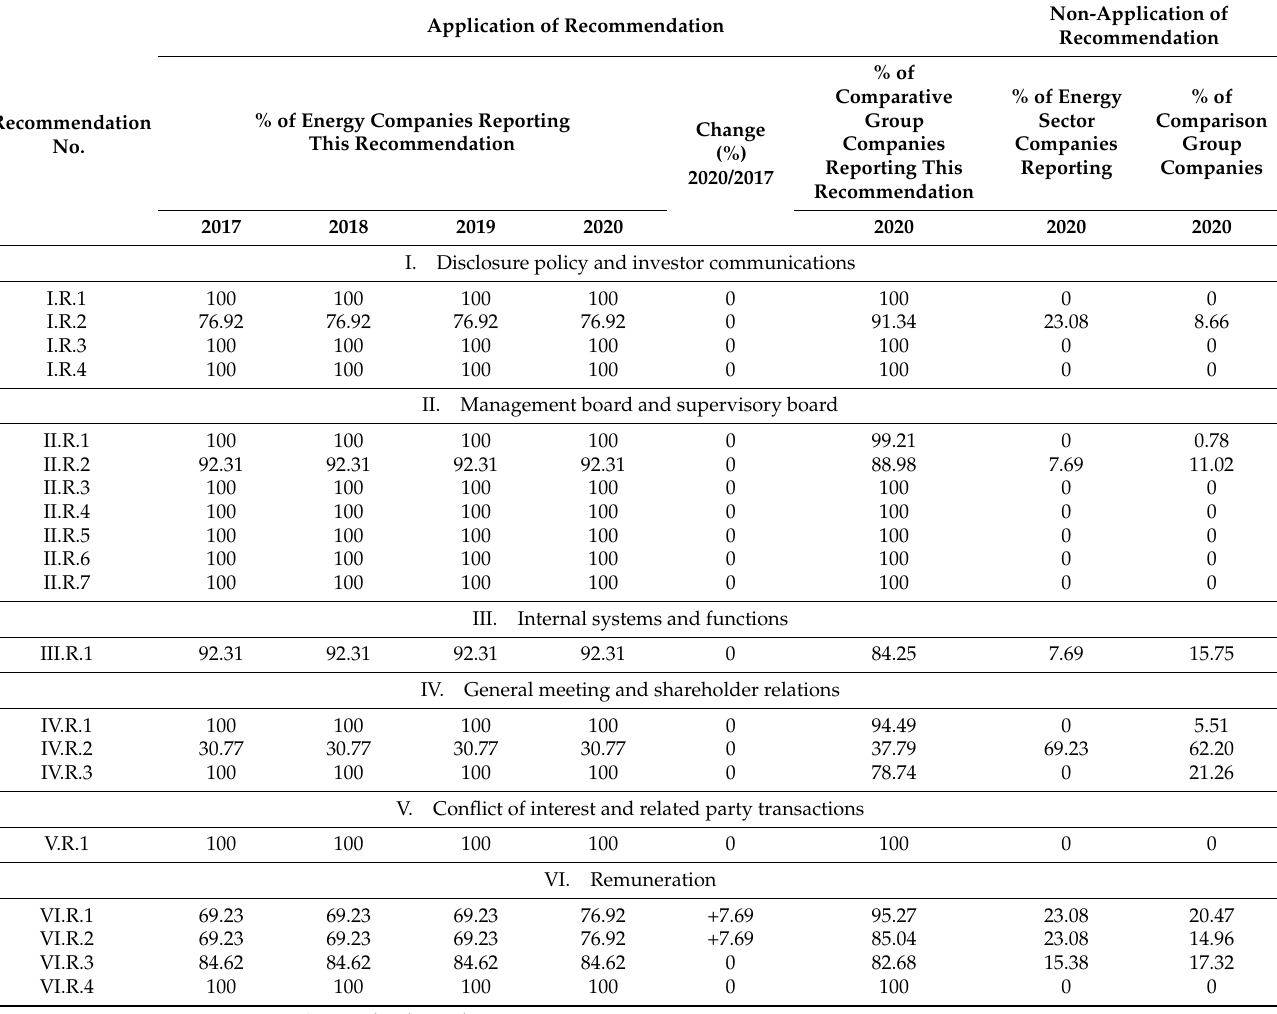
Table 3. Percentage of companies reporting in line with the recommendations of the BPs for WSE-LCs.